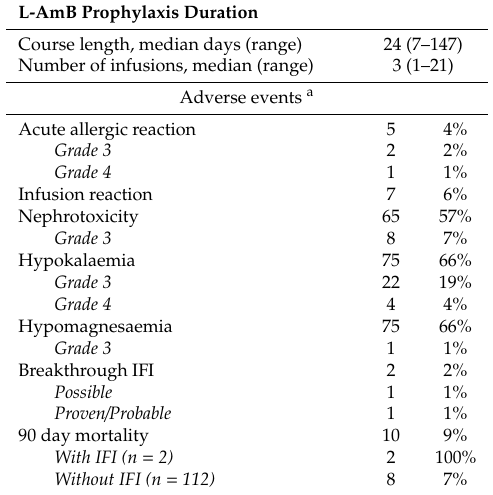
Table 3. Adverse events, breakthrough IFI and mortality ( n =